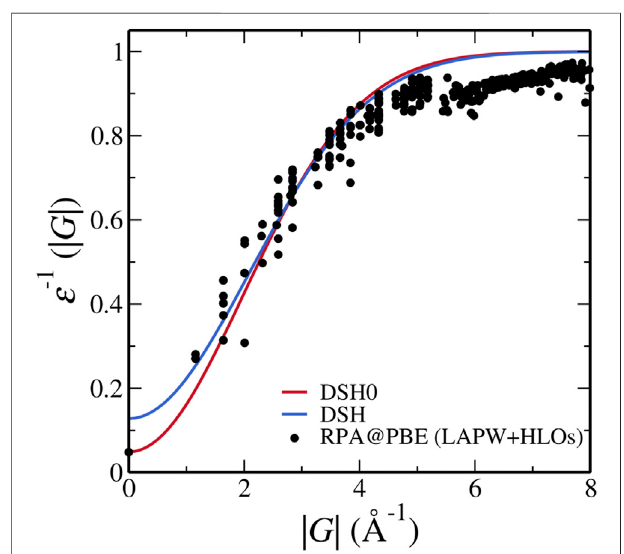
FIGURE 7 | Inverse dielectric functions of pyrite used in the DSH model and calculated from RPA@PBE with the LAPW + HLOs basis set. Dielectric constant computed by PBE is used in the one-shot DSH0